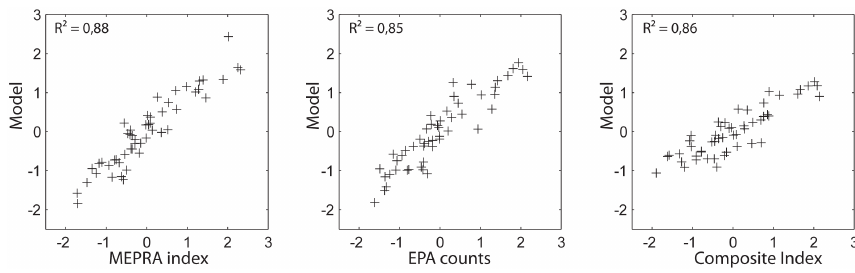
Fig. 3. Scatter plots of regression models versus response variables for the whole French